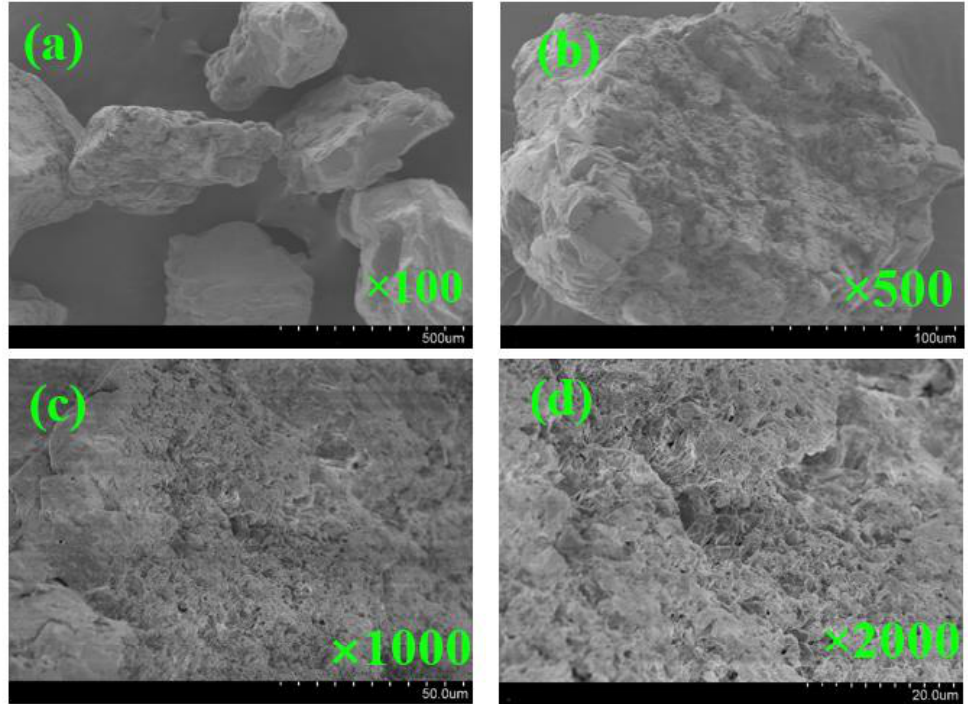
Figure 2. Scanning electron microscope (SEM) images of natural sand at different magnifications.